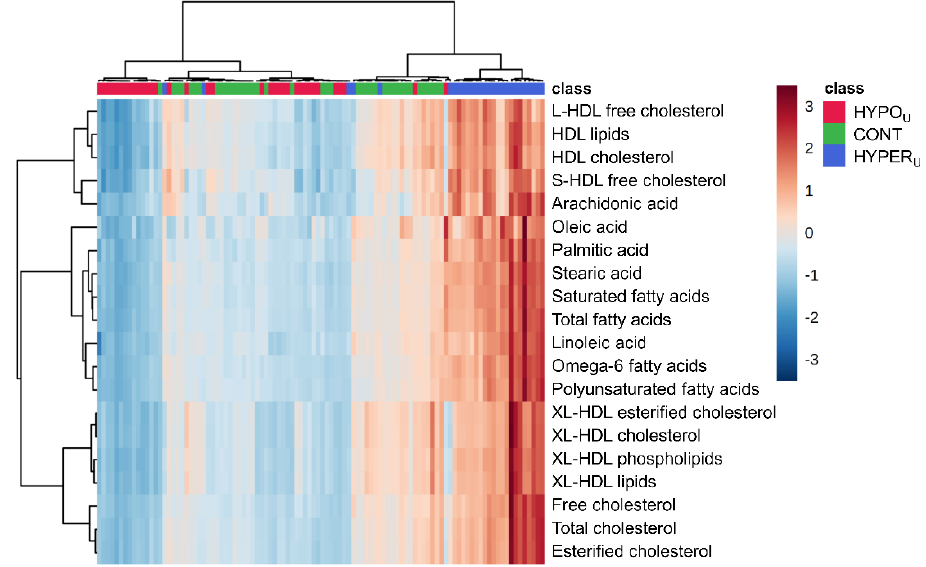
Figure 3. Hierarchical cluster heatmap (for samples and variables) of serum metabolomics data of canine samples in hyperadrenocorticism untreated (HYPER U , n = 27, blue), hypoadrenocorticism untreated (HYPO U , n = 35, red), and control (CONT, n = 40, green) groups. The top 20 parameters identified by partial least squares–discriminant analysis (PLS-DA) variable importance in projection (VIP) scores of component 1 were used. Each column represents one serum sample with group markings colored at the top. The colored legend on the right indicates the relative metabolite concentrations with different red and blue intensities indicating high and low values, respectively. Horizontal and vertical black lines depict clustering of samples and parameters.